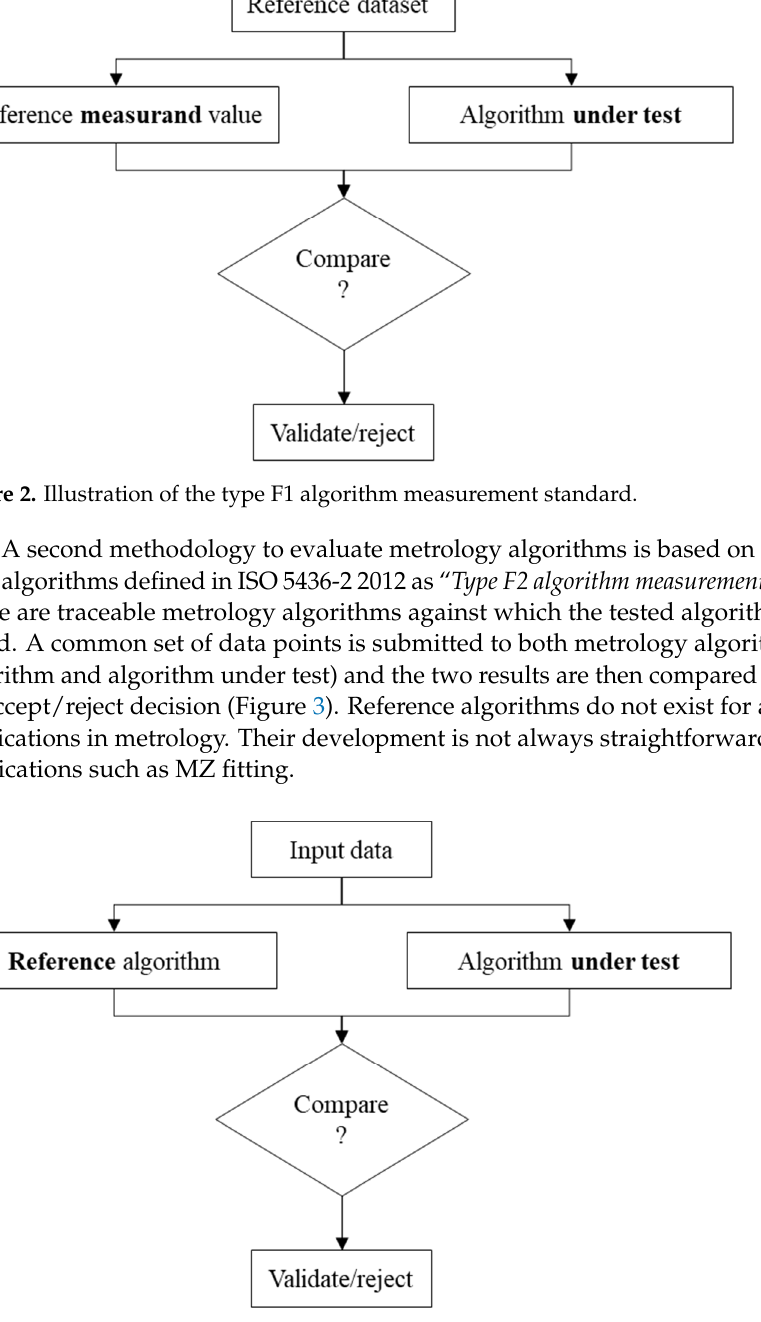
Figure 3. Illustration of the type F2 algorithm measurement standard.